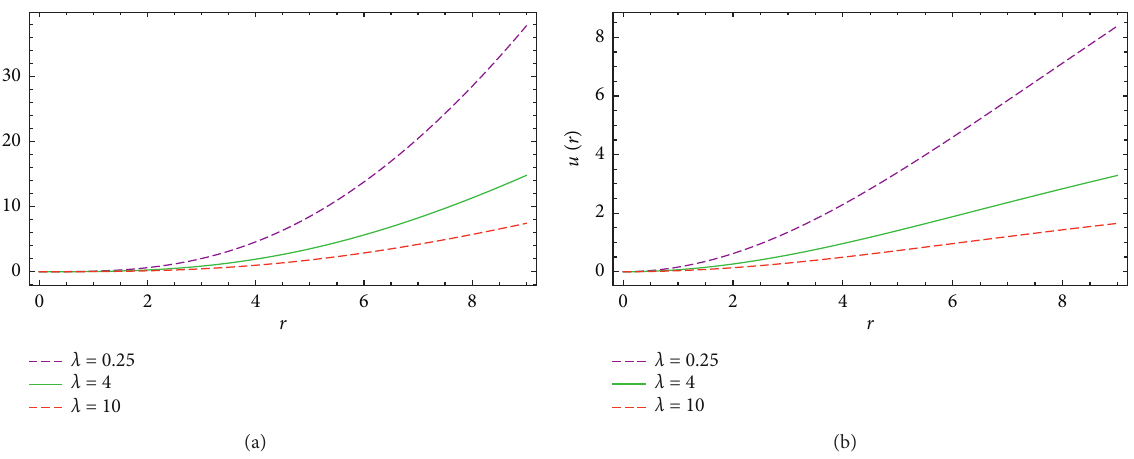
Figure 7: The behavior of energy conditions for different λ values: λ � 0 . 25 , 4, and 10 for Vela X-1.